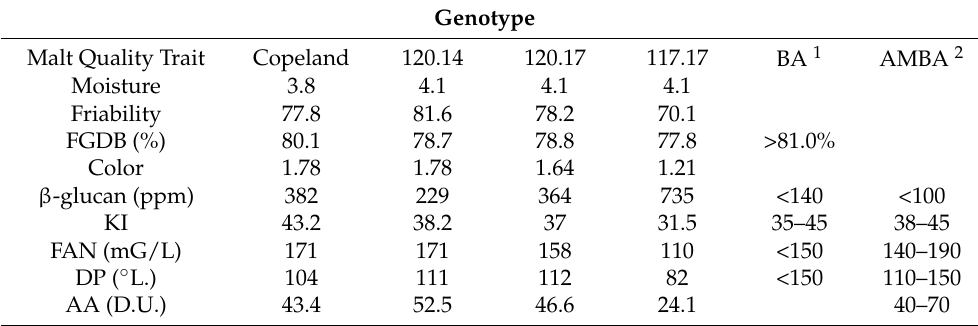
Table 3. Malt quality data presented for the commercial-scale malts used to produce the beers for the consumer sensory